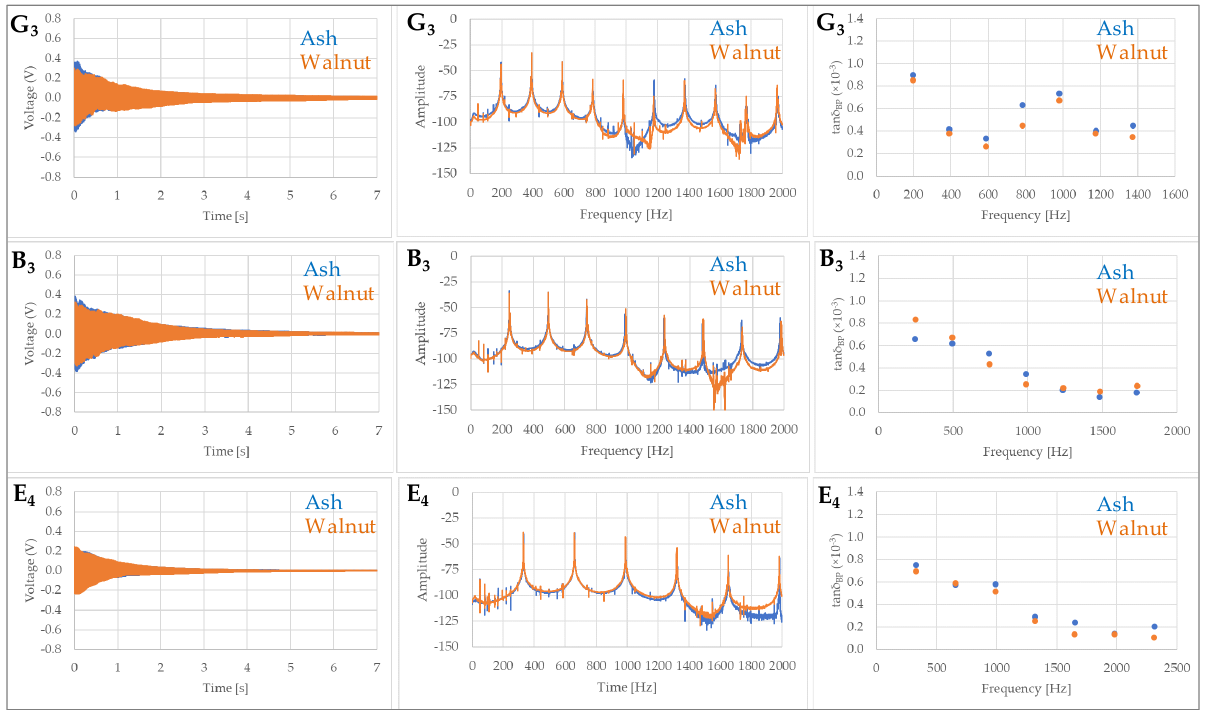
Figure 7. Measured wavelet time signal, FFT frequency spectra and damping coefficient in the first 7 vibration modes of the open strings (G 3 —top; B 3 —middle, E 4 —bottom) of an electric guitar with body made of ash wood ( ― ) and walnut wood ( — ).